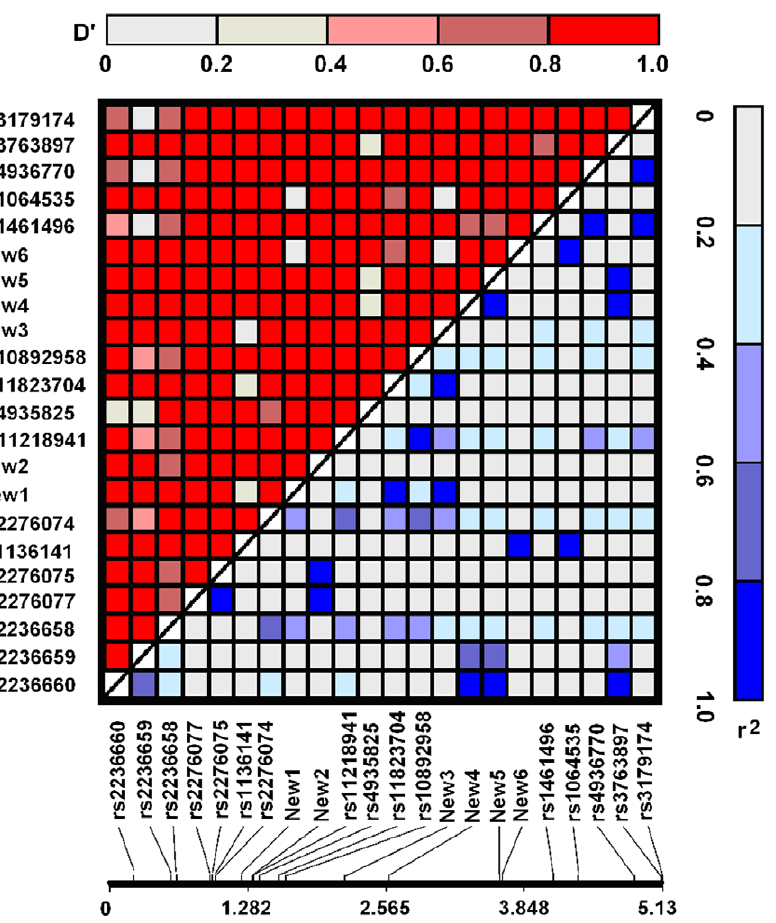
Figure 1. Linkage disequilibrium (D’ and r 2 ) between single nucleotide polymorphisms in HSPA8 gene. Based on the data on the resequencing of the HSPA8 gene, a total of 22 single nucleotide polymorphisms were analyzed by JLIN software to analyze linkage disequilibrium (D’ and r 2 ) between SNPs.